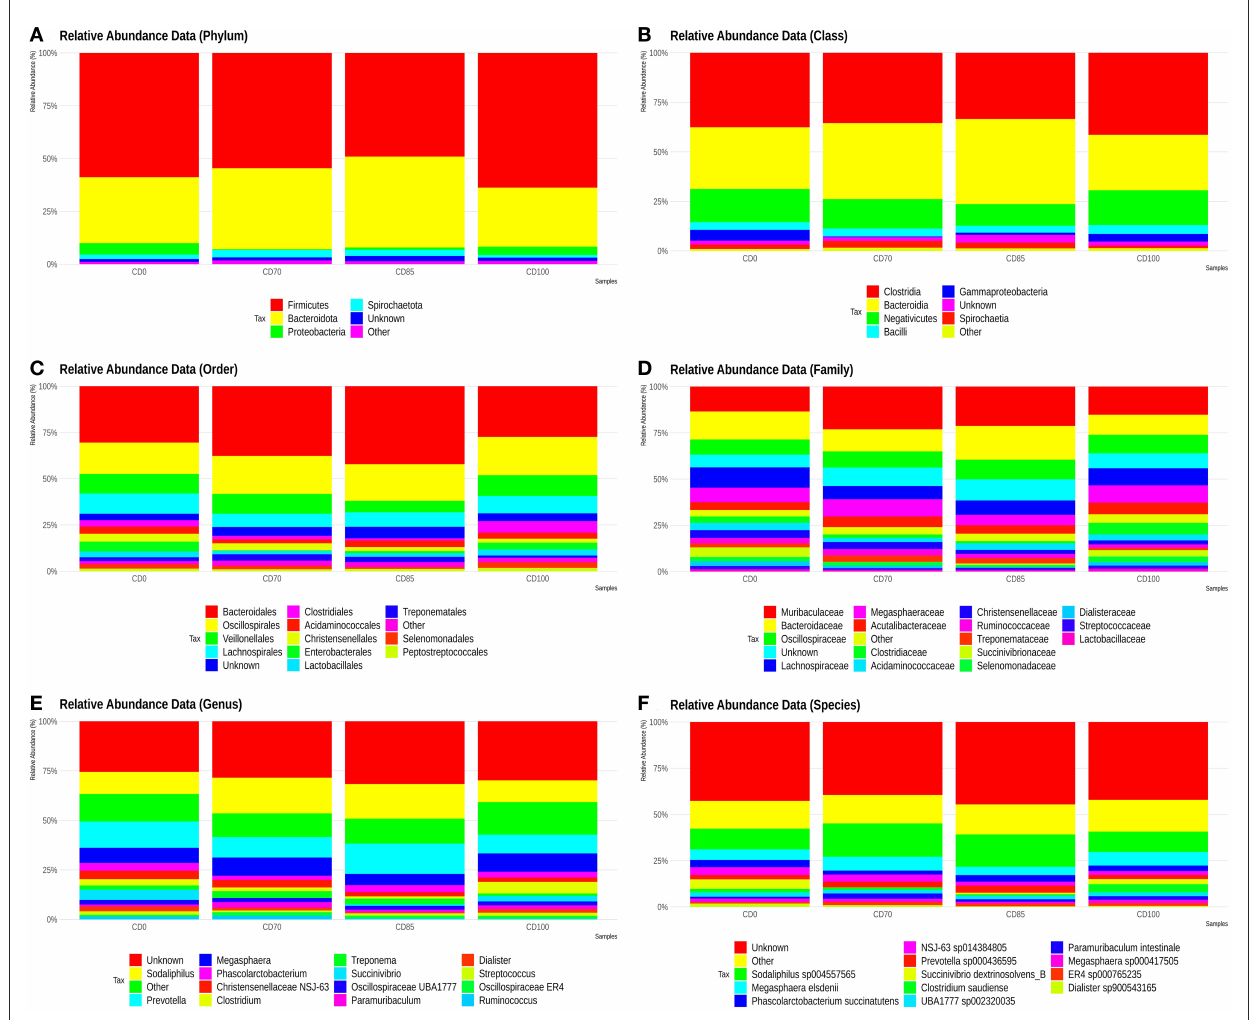
FIGURE3 Relative abundance of phyla (A) , classes (B) , orders (C) , families (D) , genera (E) , and species (F) presents in finisher pigs fed 1 of 4 dietary treatments: a control diet containing isolated phytase and xylanase valued at 40 kcal of ME/kg (CD0), CD0 + β -mannanase (0.3 g/kg valued at 30 kcal of ME/kg) (CD70), CD0 + β -mannanase (0.3 g/kg valued at 45 kcal of ME/kg) (CD85), and CD0 + β -mannanase (0.3 g/kg valued at 60 kcal of ME/kg) (CD100). Data are averages of 6 pigs per dietary